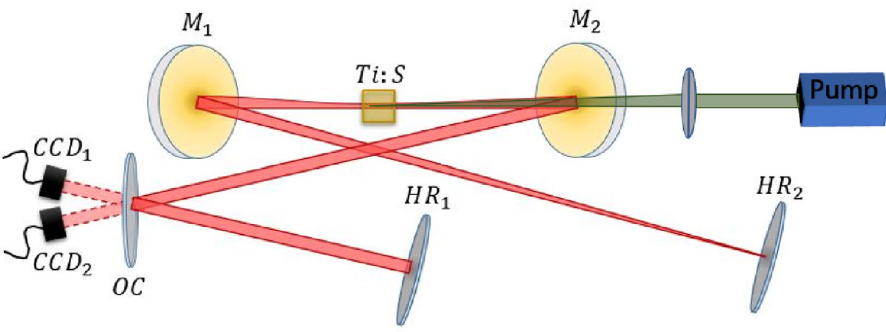
Figure 3. Experimental configuration: We employ a standard X-folded four-mirror cavity. M 1,2 are spherical mirrors with focus f = 75mm . HR 1,2 are the highly reflecting end mirrors (flat). OC is the output coupler used to probe the beam twice in each round-trip. A pair of BK7 prisms is deployed to compensate for intra-cavity dispersion (not shown). The gain medium (and Kerr medium) is a Brewster-cut 3mm long Ti:Sapphire crystal (0.25% doped), pumped by a 4W–6W laser at 532 nm (Verdi V18 by Coherent). The generated pulses have a repetition rate of 67 MHz and a duration of roughly 50 fs.